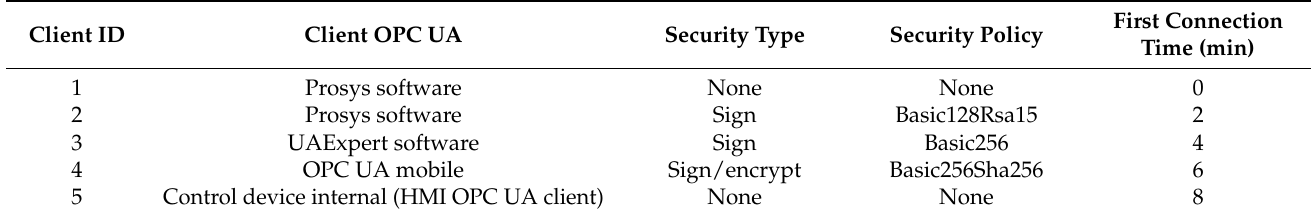
Table 1. Sequence of client connections to the control device OPC UA